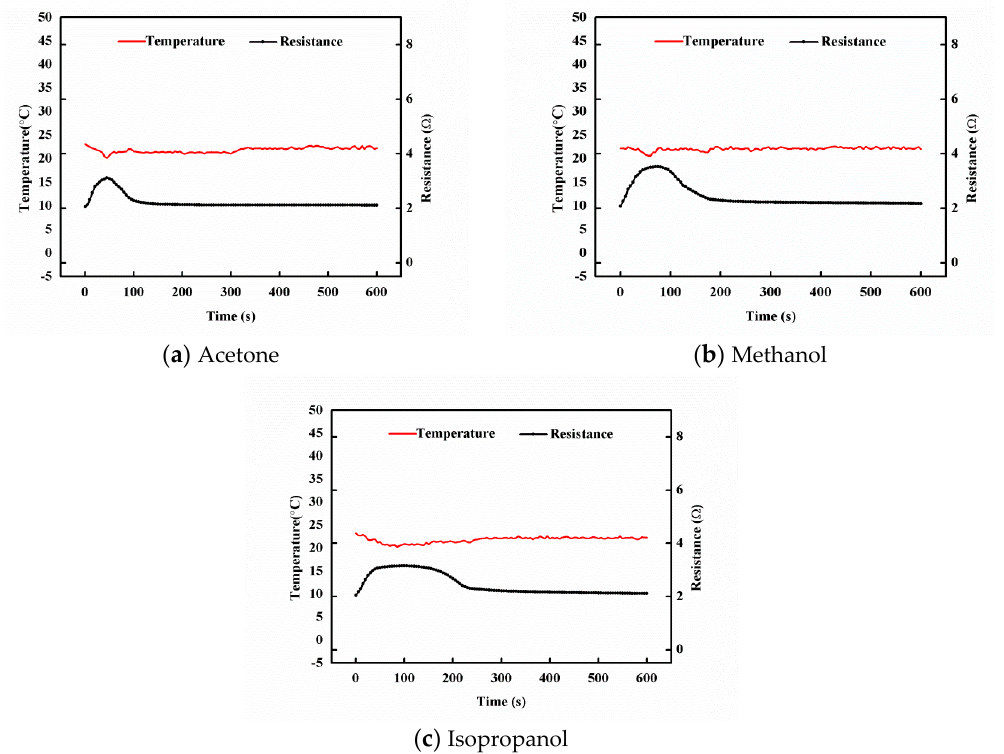
Figure 16. Temperature and resistance responses of the hybrid film GNP-50 titrated with 100 µ L of acetone, methanol, and isopropanol.